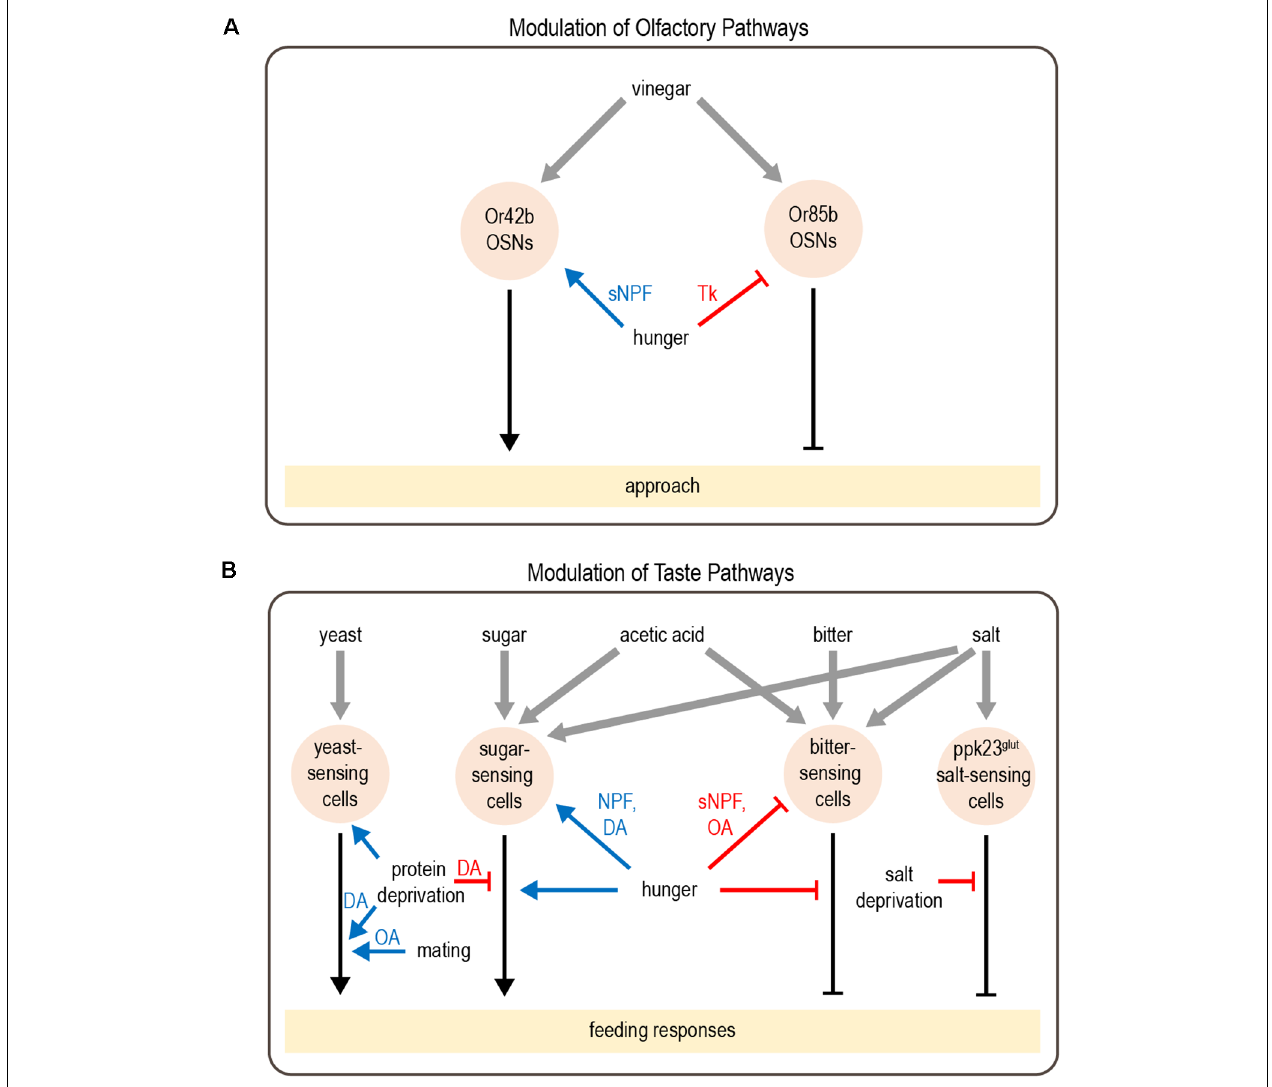
FIGURE 2 | Modulation of olfactory and taste pathways by internal states. (A) Parallel olfactory pathways are modulated by hunger at the level of sensory neuron output. (B) A variety of taste pathways are modulated by states such as hunger, protein or salt deprivation, or mating. This modulation can act at the level of sensory neurons or downstream. Most downstream neuronal targets of modulation have not yet been identified. Abbreviations not defined in text: tachykinin (Tk); octopamine (OA); dopamine (DA). Gray arrows depict sensory input; black arrows depict neural circuits that generate behavior; blue arrows depict excitatory modulation whereas red arrows depict inhibitory